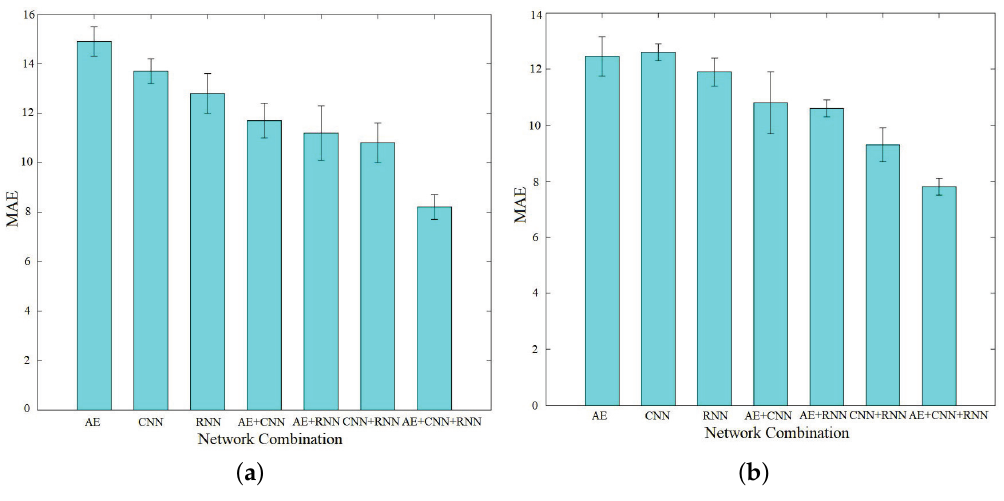
Figure 4. Different combinations of networks. ( a ) Results of IMDB; ( b ) Results of